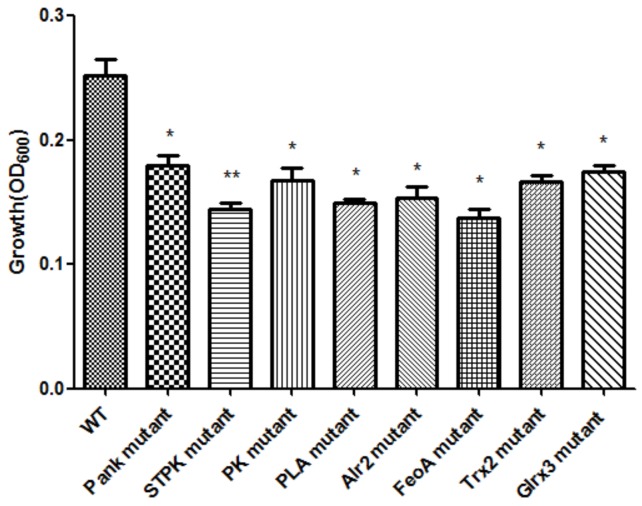
Growth of C. malonaticus wild strain (WT) and mutants under 1.0 mM H2O2 oxidative stress. Bar = mean ± SD. ∗Significant difference about growth under 1.0 mM H202 with WT strain (p < 0.05), ∗∗significant difference about growth under 1.0 mM H202 with WT strain (p < 0.01).